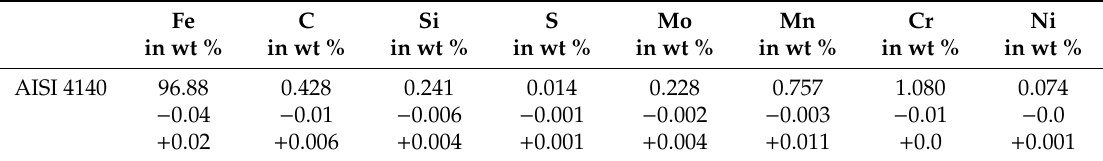
Table 1. Chemical composition of tested AISI 4140 material determined by spark spectrometry (selected elements) average of five tests and range of